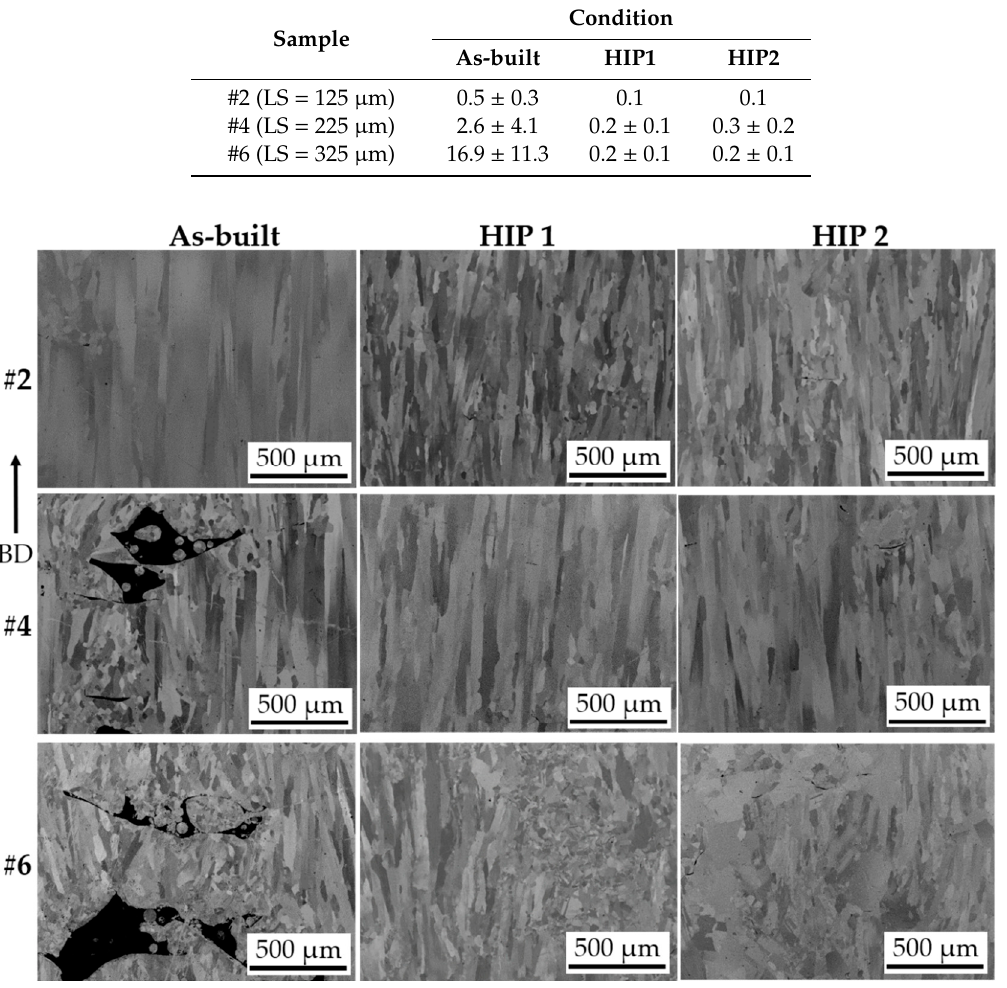
Figure 4. Representative EDS analysis showing inclusions typically associated with many remnant defects in sample #4 (LS = 225 µm) after HIP1. The arrow indicates the build direction. It is pertinent to note that concerns regarding thermally induced porosity (TIP), i.e., regrowth of apparently “closed” defects during subsequent heat treatment, have been reported [25,26]. Therefore, the samples HIP1#2, #4, and #6 were also subjected to heat treatment at 1180° C/4 h under vacuum, as previously studied by Benn et al. [26]. The results showed no significant difference in defect content before and after the heat treatment. Therefore, the TIP phenomenon was not discernible in the present HIP’ed EBM built Alloy 718 samples, at least to a statistically discernible limit, thereby indicating the efficacy of defect closure achieved by HIPing. It is worth mentioning that TIP plausibly did not happen in the